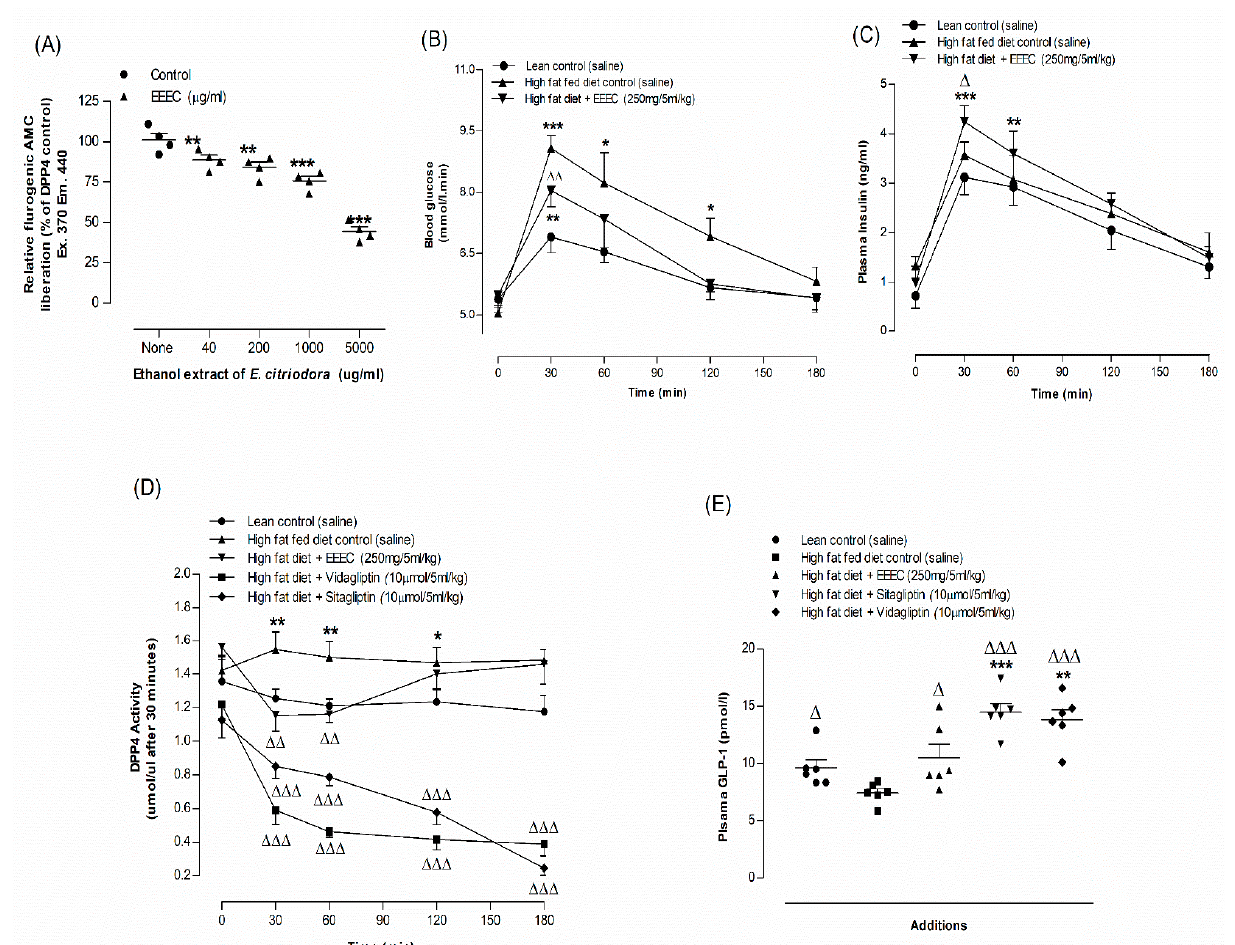
Figure 4. Effects of EEEC on ( A ) DPP-IV enzyme in vitro, ( B ) glucose tolerance, ( C ) plasma insulin, ( D ) DPP-IV and ( E ) plasma active GLP-1 (7–36) in high-fat-fed rats. In vivo parameters were evaluated before and after oral gavage of glucose alone (18 mmol/kg body weight, control) or with EEEC (250 mg/5 mL/kg body weight), sitagliptin and vidagliptin (both at 10 µmol /5 mL/kg, body weight). Plasma active GLP-1 (7–36) levels was assayed at 30 min after treatments. Values n = 4 for in vitro DPP-IV enzyme activity and n = 6 for in vivo parameters are mean ± SEM. * p <0.05, ** p <0.01 and *** p < 0.001 compared to lean control and Δ p < 0.05, ΔΔ p < 0.01 and ΔΔΔ p < 0.001 compared to high-fat-fed diet control rats.